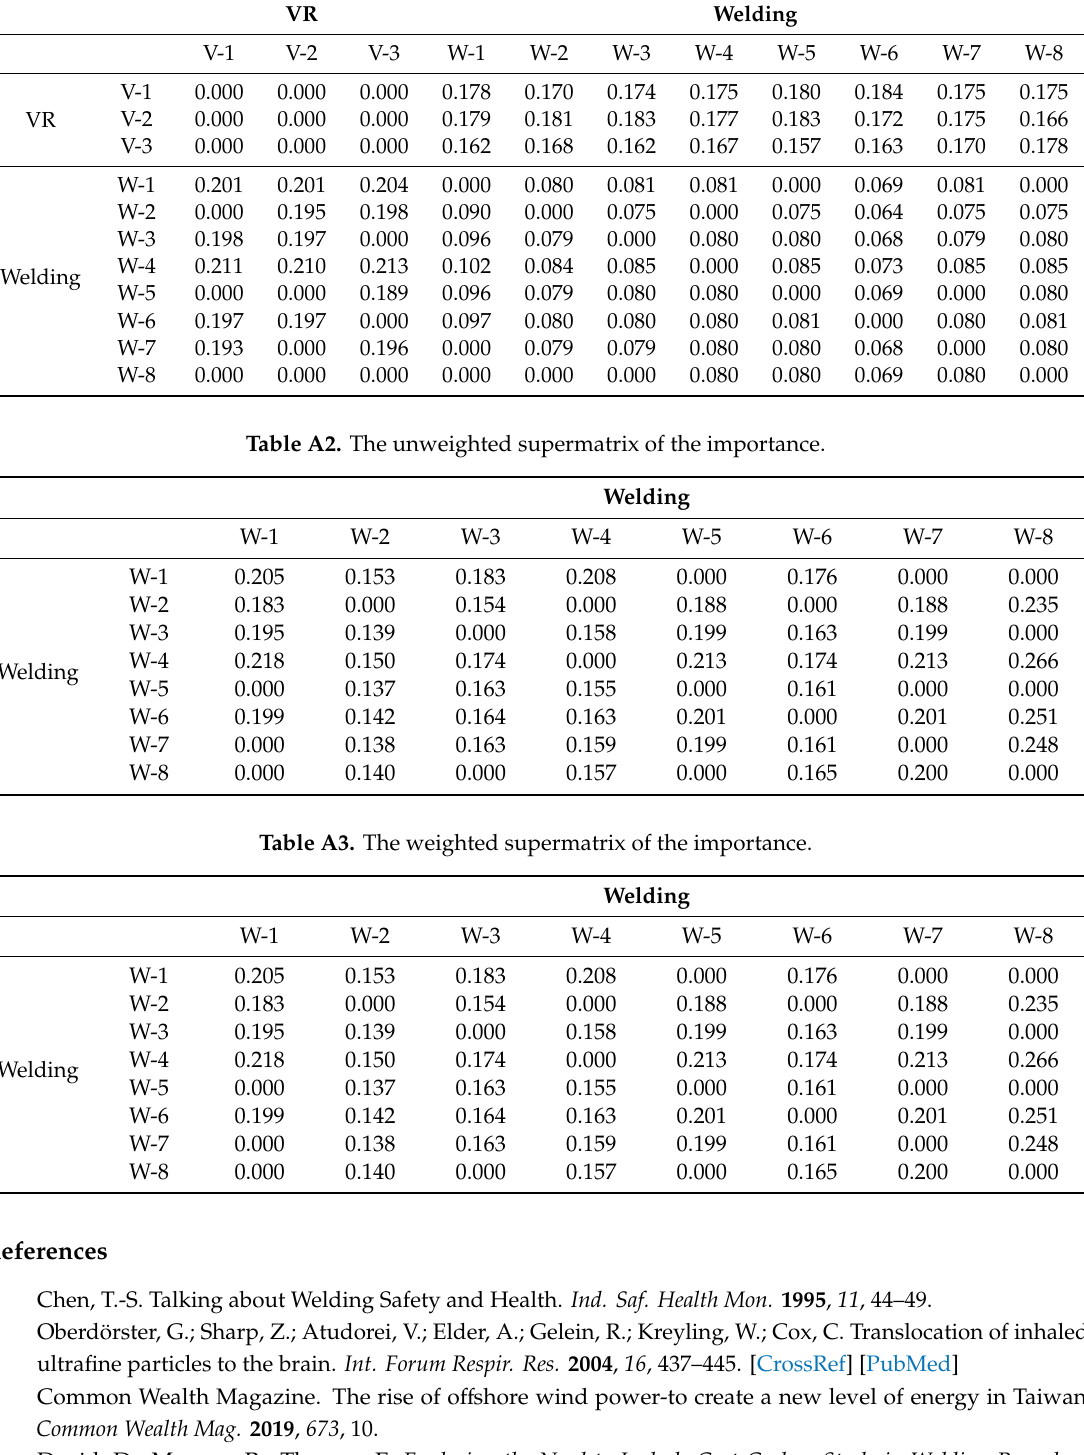
Table A1. The weighted supermatrix of the feasibility.